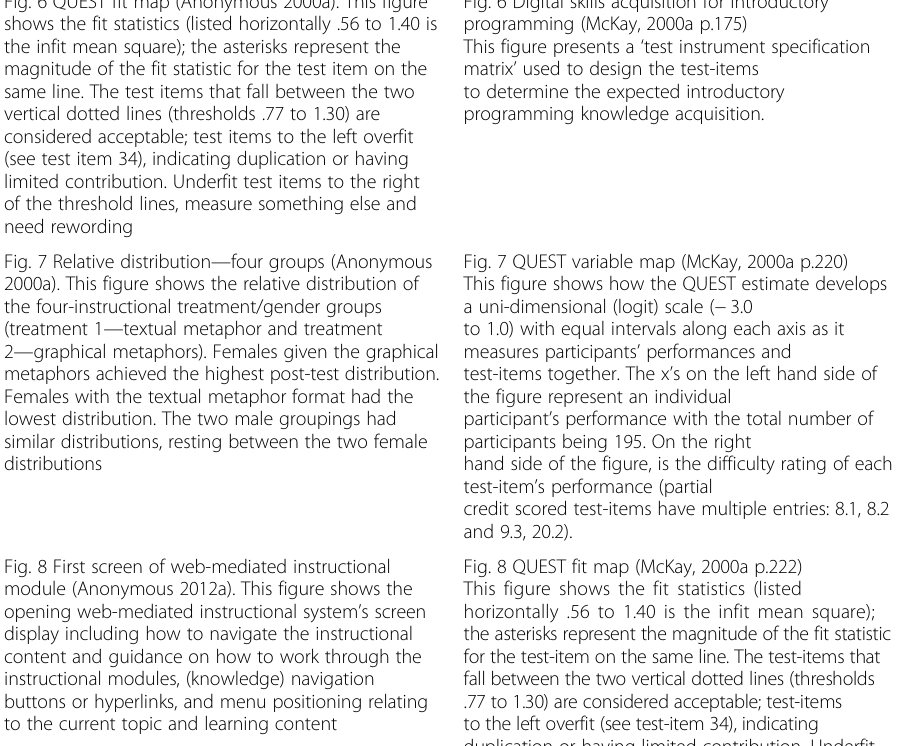
Fig. 10 First screen of web-mediated instructional module (Mohamad, 2012